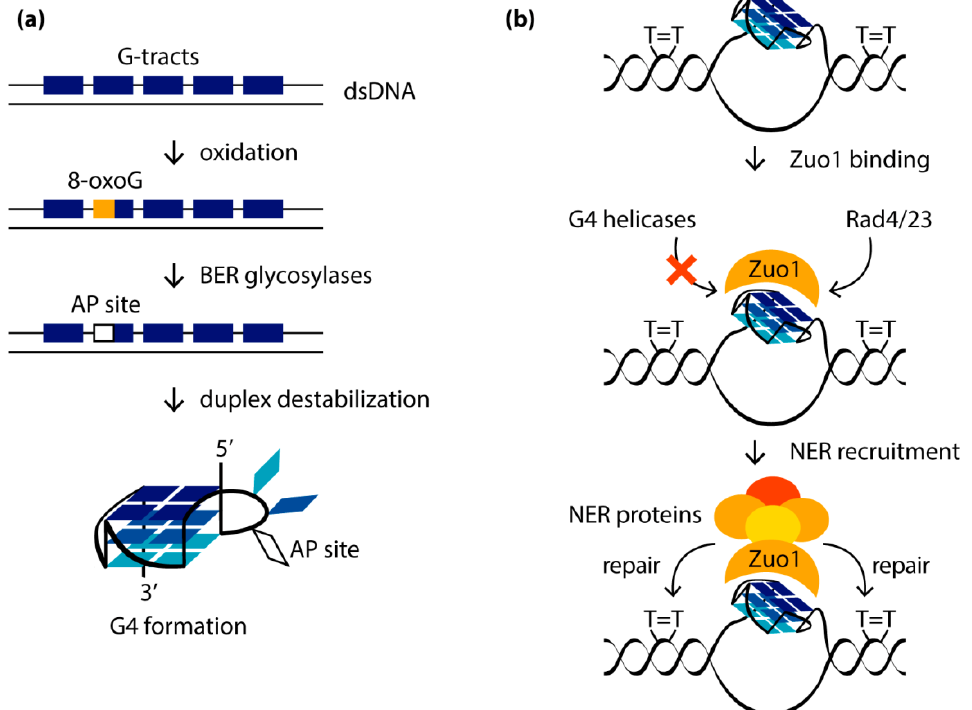
Figure 6. ( a ) Induction of BER-dependent G4 formation by oxidative stress. Removal of 8-oxoG by OGG1 glycosylase results in an AP site that destabilizes the DNA duplex and makes the formation of G4 by a G4 motif with five G-tracts more favorable. ( b ) Recognition, stabilization and protection against G4-unwinding helicases of G4 structures by the Zuo1 protein stimulates the repair of UV-induced damage (T=T corresponds to thymine dimer) via the NER pathway by recruiting the Rad4/23 complex.